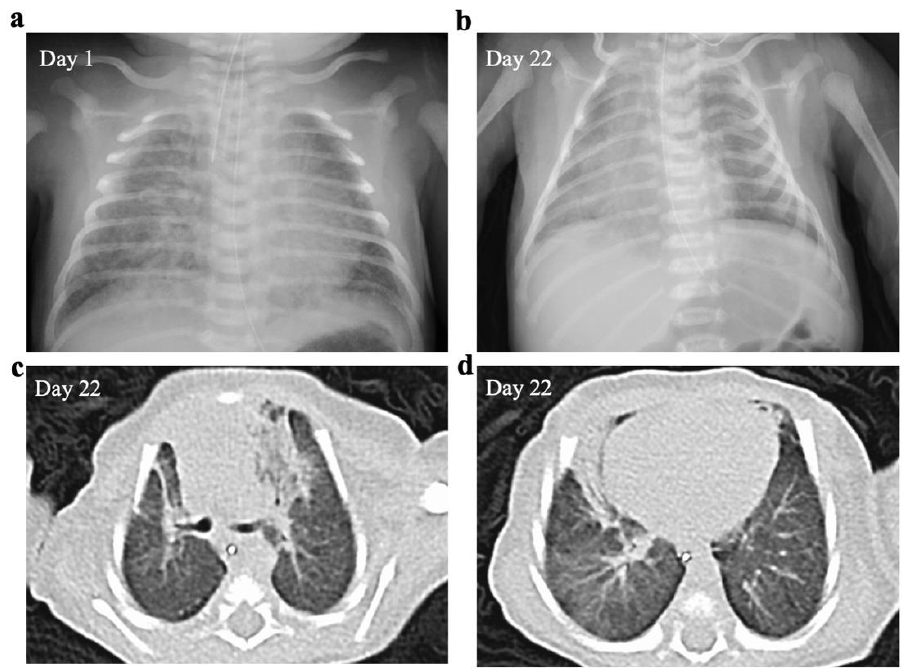
Figure 1. Chest radiograph and computed tomography (CT) scan. The chest radiograph displays bilateral hazy opacities ( a ). The chest radiograph ( b ) and CT examination ( c , d ) performed at 22 days of age reveal infiltrative shadows in both lung fields and decreased lung capacity.